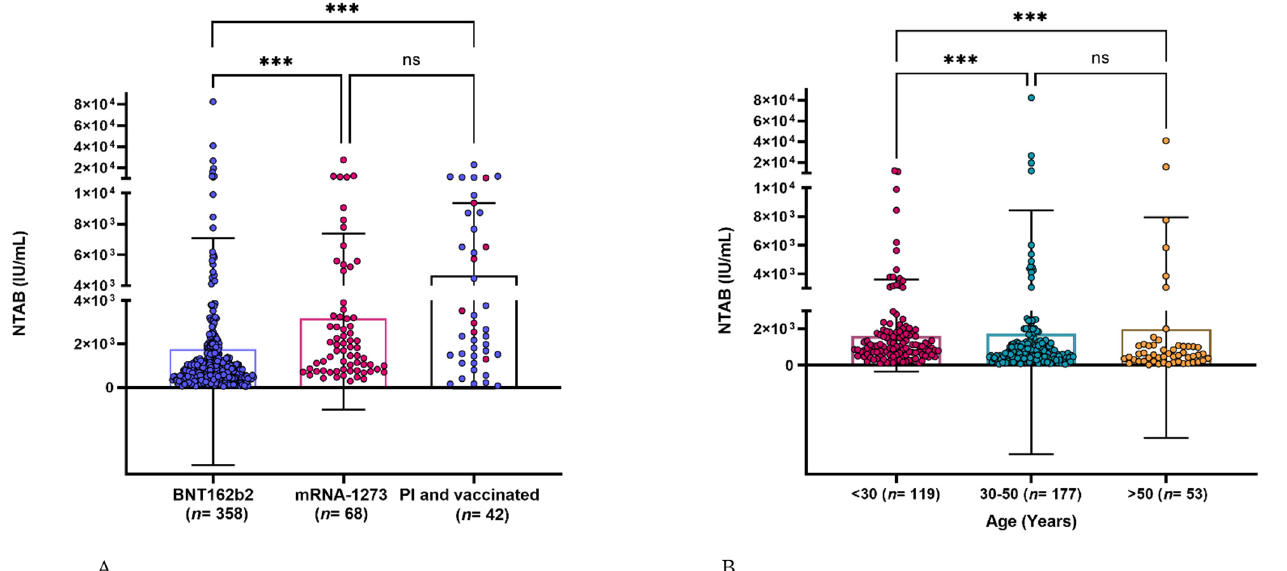
Figure 1. ( A ) NAb levels (IU/mL) in mRNA vaccinated participants 1–26 weeks after receiving two doses, and participants with prior infection and two doses of the vaccine. ( B ) NAb levels (IU/mL) in BNT162b2-vaccinated participants according to age groups. The tests were performed using the automated analyzer Mindray Cl-900i. Asterisks on graphs denote * p ≤ 0.05, ** p ≤ 0.01, and *** p ≤ 0.001; ns p > 0.05.